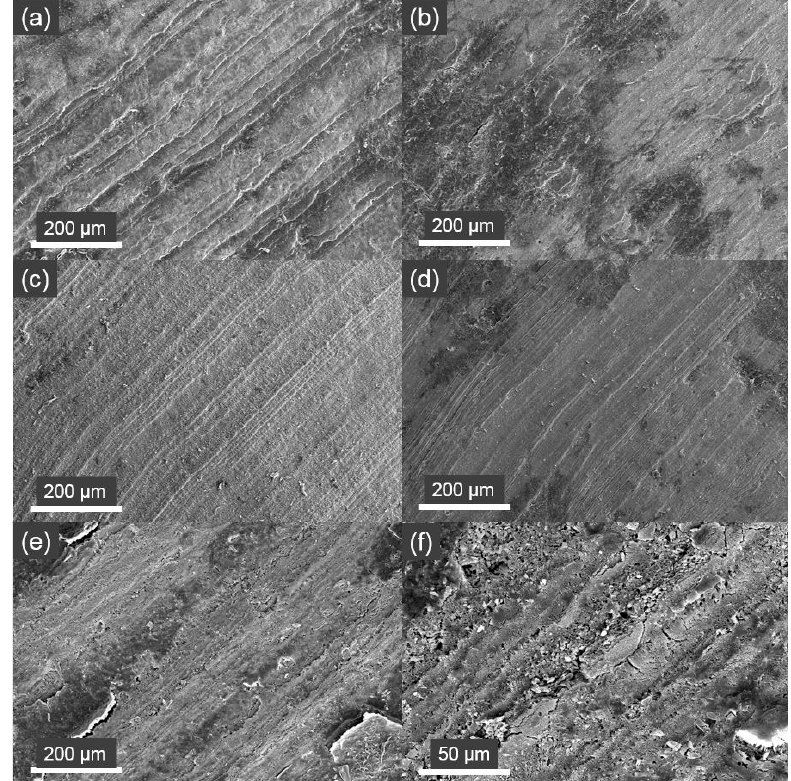
Figure 5. SEM image of the shell surface of Nacella concinna in each group. It showed the height of the growth decreased (flatness) when the aragonite saturation state was lower. Individuals in the LPLS group showed both flatness ( d ) and ruggedness ( e,f ) due to the dissolution of the shell surface. ( a ) An example of group C, ( b ) an example of group LS, ( c ) an example of group LP, ( d,e ) examples of group LPLS, and ( f ) magnified picture of ( e ).